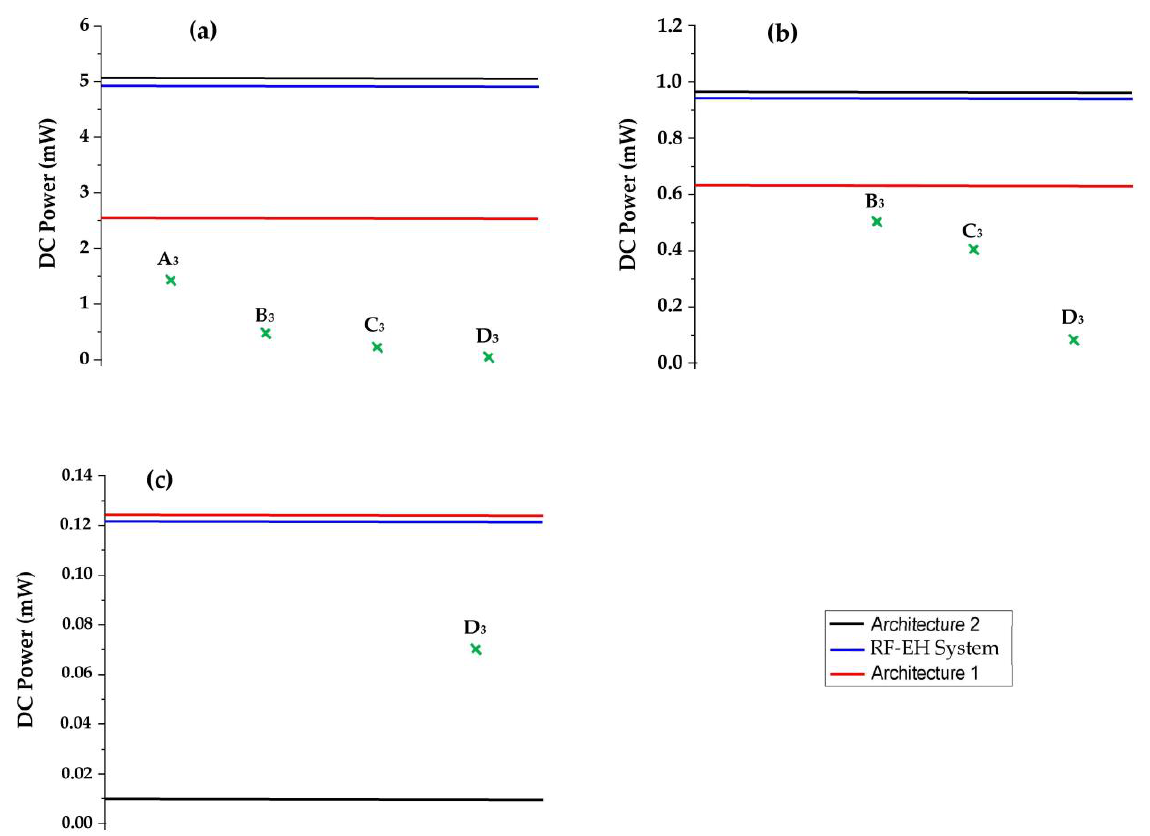
Figure 33 . Feeding ability of the RF-EH system and architectures at ( a ): 22 m, ( b ): 40 m, and ( c ): 110 m from relay antenna compared to minimum required power supply of the pressure sensors. The DC powers A 3 , B 3 , C 3 and D 3 correspond to the power supply of sensors cited in the references [36 – 39], respectively .